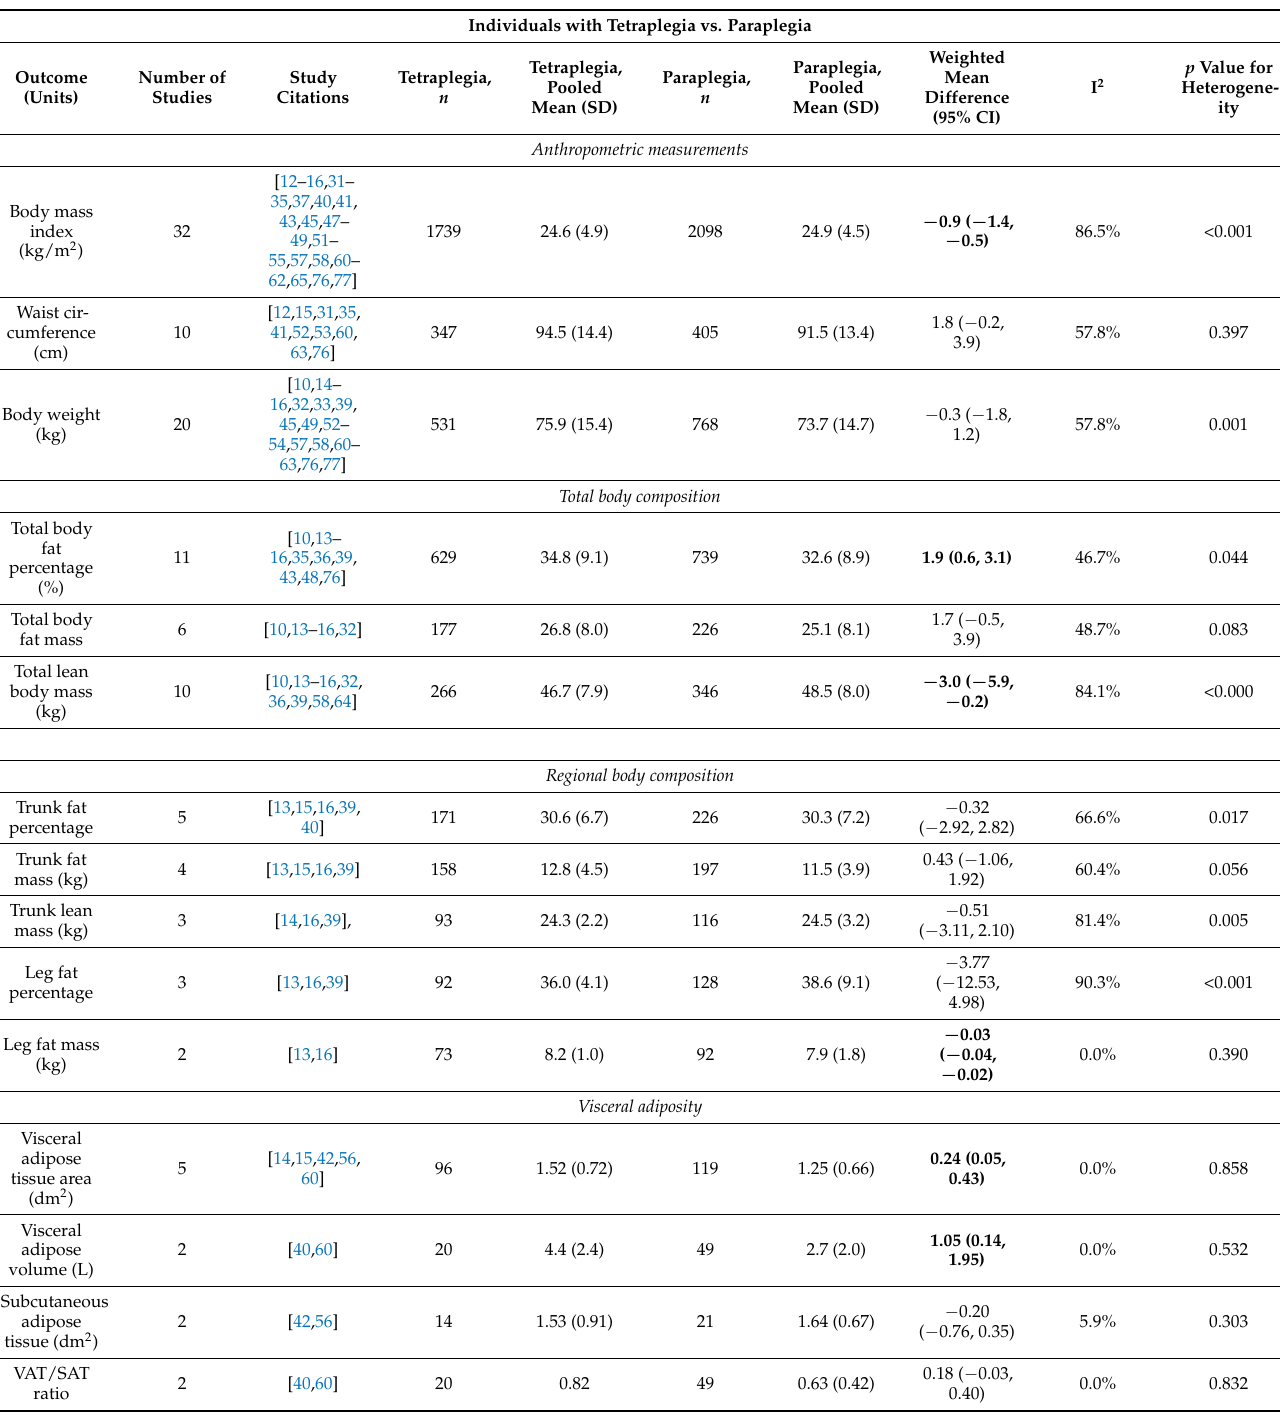
Table 2. Weighted mean difference of anthropometric measures and body composition among spinal cord injury patients. Individuals with Tetraplegia vs.